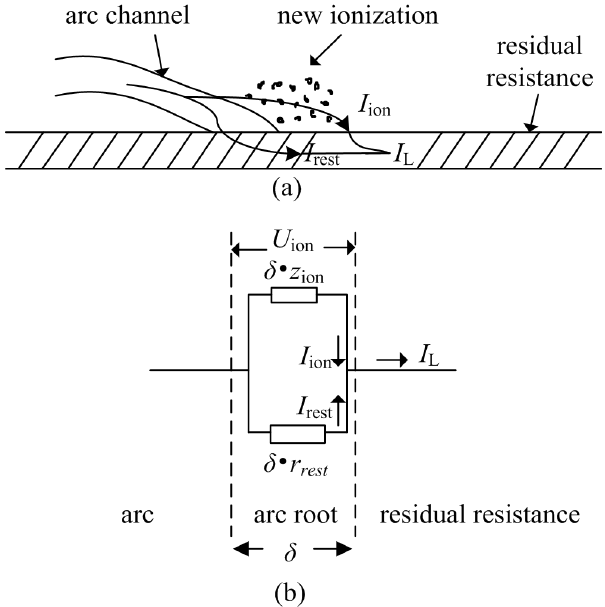
Figure 2. Arc root equivalent electrical circuit model. ( a ) Arc root physical analysis; ( b ) Arc root equivalent electrical